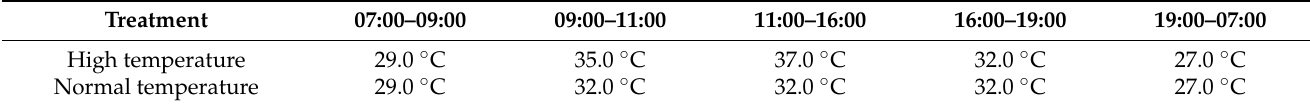
Table 1. The temperature settings at different times between high-temperature and normal- tempera- ture